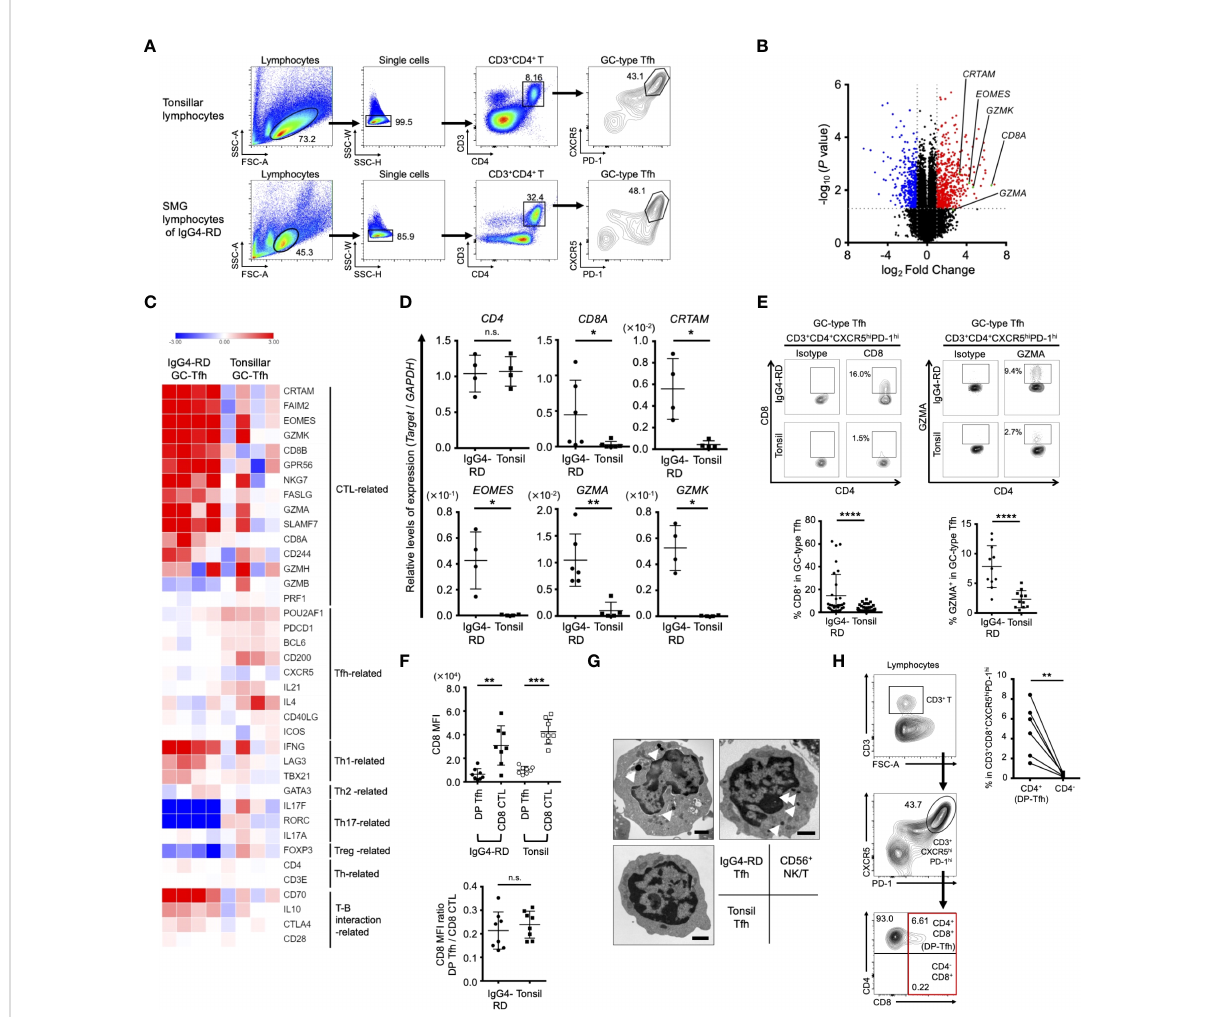
FIGURE 1 Phenotypic characteristics of GC-type Tfh cells in IgG4-RD lesions. (A) Flow cytometry pro fi les showing selected windows and gating strategy applied to identify GC-type Tfh cells (CD3 + CD4 + CXCR5 hi PD-1 hi ) in lymphocytes of tonsils and SMG lesions of IgG4-RD. (B) Volcano plot identifying differentially expressed genes ( p < 0.05) with more than two-fold expression in GC-type Tfh cells localized in SMG lesions of IgG4-RD versus GC-type Tfh cells in tonsils. The red and blue dots indicate upregulated and downregulated genes, respectively, in the Tfh cells of IgG4-RD. Data were obtained from microarray analysis of four specimens in each experiment group of IgG4-RD lesions or tonsils. (C) Heat map indicating relative abundances of transcripts identi fi ed in (A) for selected genes regulating helper CD4 + T cells and CTLs. Relative values of gene expression are indicated by color. (D) Relative expression levels of genes in GC-type Tfh cells in the SMG lesions of IgG4-RD and tonsils as indicated in (C) assessed by RT-qPCR analysis. GAPDH was used as a control (IgG4-RD, n = 4-6; tonsil, n = 4-6). (E) Representative fl ow cytometry pro fi les of the expression of CD8 and granzyme A (GZMA) in GC-type Tfh cells in SMG lesions of IgG4-RD and tonsils (upper panels). Graphs indicating the expression of CD8 (IgG4-RD, n = 31; tonsil, n = 71) and GZMA (IgG4-RD, n = 11; tonsil, n = 11) in GC-type Tfh cells as assessed by fl ow cytometry (lower panels). (F) Expression levels of CD8 on DP-Tfh cells and CD8 + CTLs in the lymphocytes of IgG4-RD lesions and tonsils (IgG4-RD, n = 8; tonsil, n = 8) assessed by fl ow cytometry. MFI, mean fl uorescence intensity. (G) Transmission electron microscopy of FACS-sorted T cells, including GC-type Tfh cells from SMG lesions of IgG4-RD and tonsils and NKT cells (CD3 + CD56 + ) from tonsils. Arrowheads indicate electron-dense granules in the cytosol. Scale bar: 1 m m. (H) DP-Tfh cells enriched in the CD3 + CD8 + CXCR5 hi PD-1 hi T cell population in tonsils. Representative fl ow cytometry pro fi les to detect DP-Tfh cells and CD3 + CD4 - CD8 + CXCR5 hi PD-1 hi T cells as indicated in the red square (left panels). A graph showing the CD3 + CD8 + CXCR5 hi PD-1 hi T cell population preferentially containing DP-Tfh cells (right). Data from the same tonsils are paired (n = 6). Data in (D – F, H) were analyzed by the Mann – Whitney U test. Data in (G) were obtained from three independent